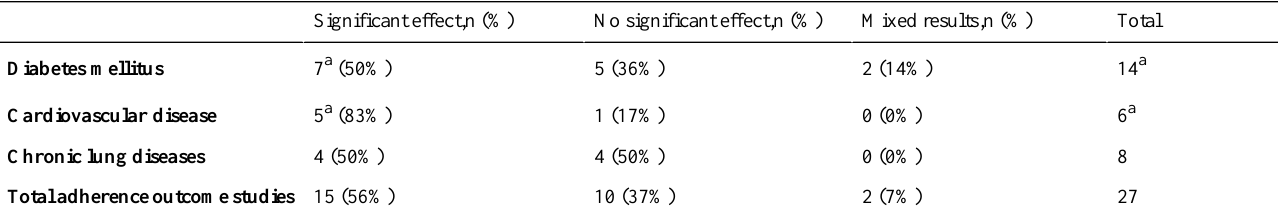
Table 2. Effectiveness of mAdherence on adherence outcomes.